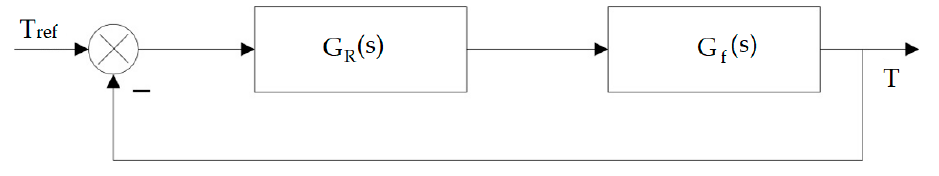
Figure 3. Temperature regulation setup in MATLAB Simulink.